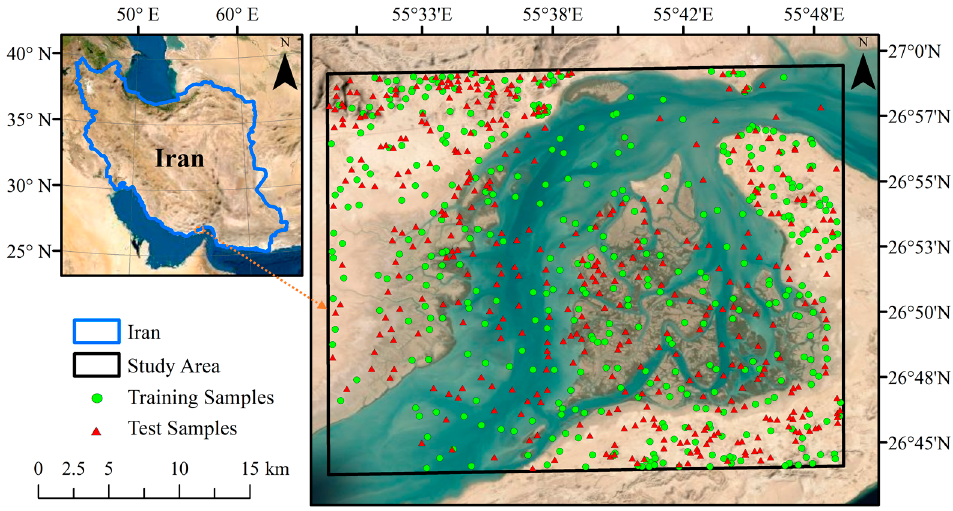
Figure 1. The geographical location of the Hara protected area of Qeshm Island in southern Iran, along with the spatial distribution of the training and test samples over the study area (see Table 1 for information about training and test samples). Table 1. The number and area of reference samples (i.e., training and test polygons) for eight classes.